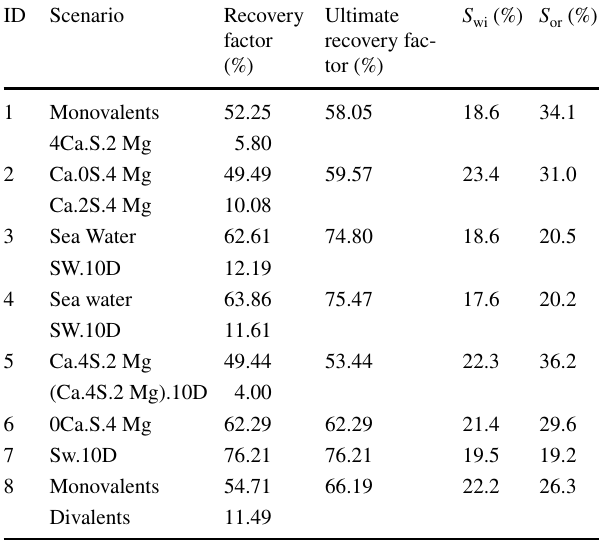
Table 6 Overview of performed scenarios on each plug at 90 °C ID